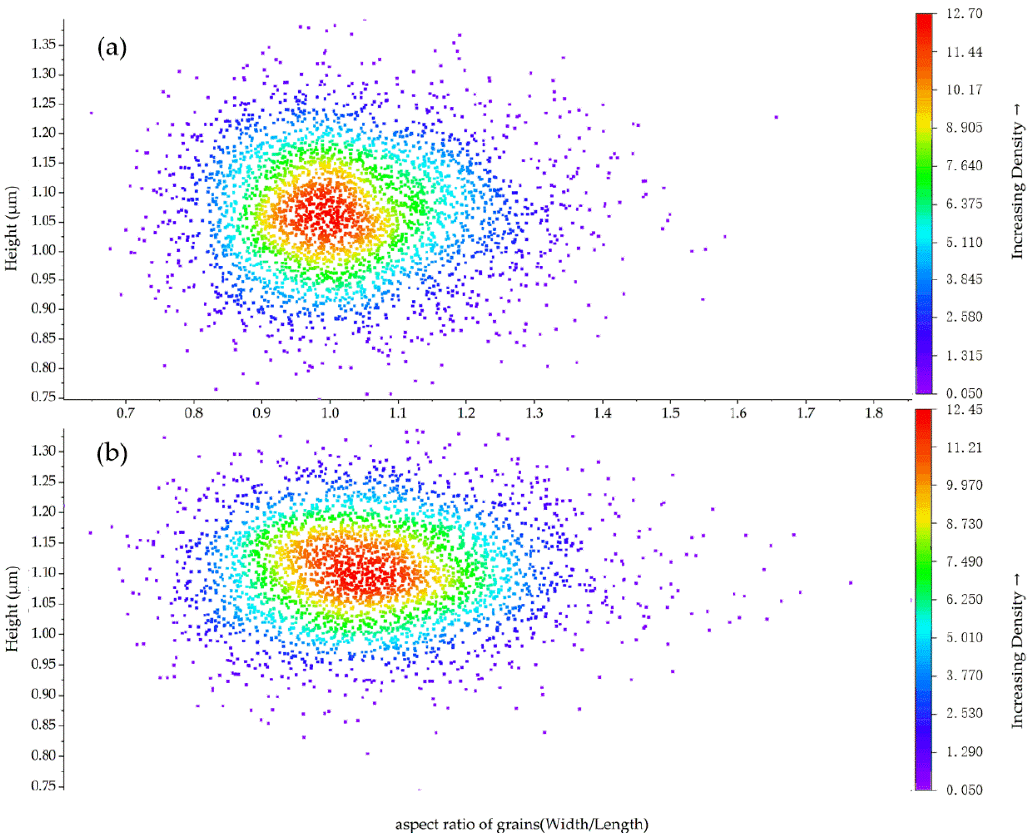
Figure 11. Distribution of grain size. ( a ) Distribution of 3505 active abrasive grains size in simulation; ( b ) Distribution of 3632 active abrasive grains size in experiment.